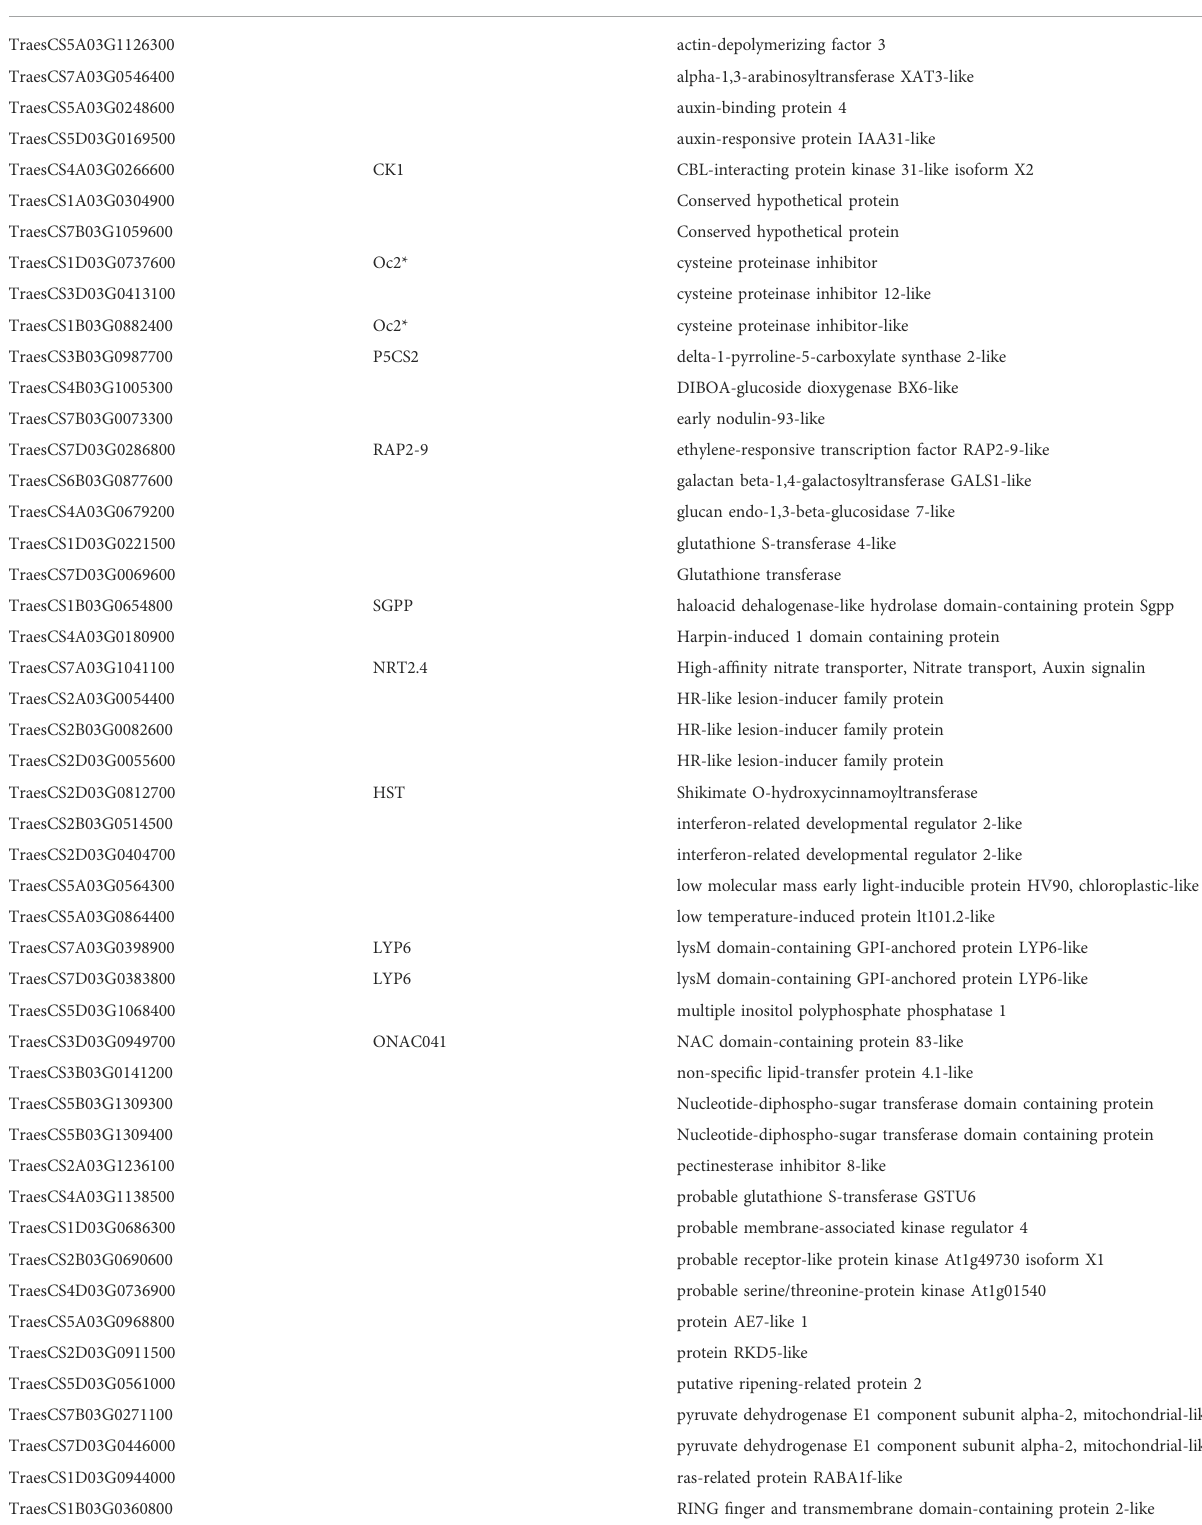
TABLE 4 Cold-Hardy